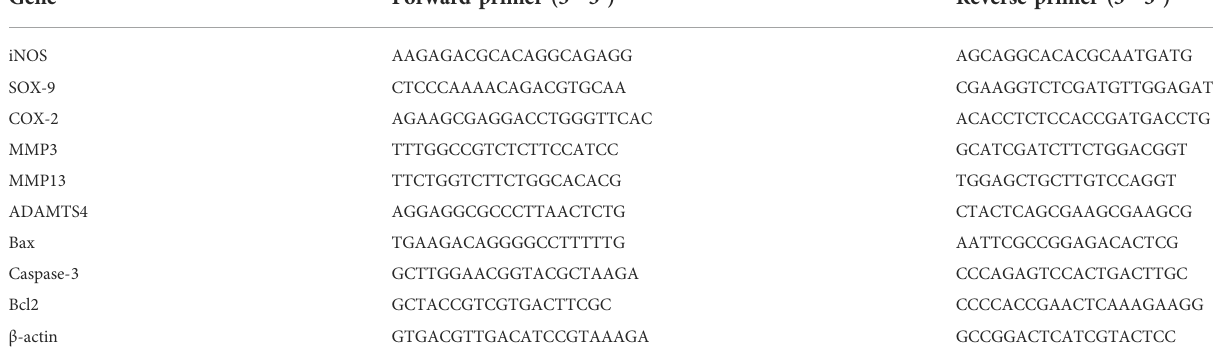
TABLE 1 The primer sequences used in qPCR